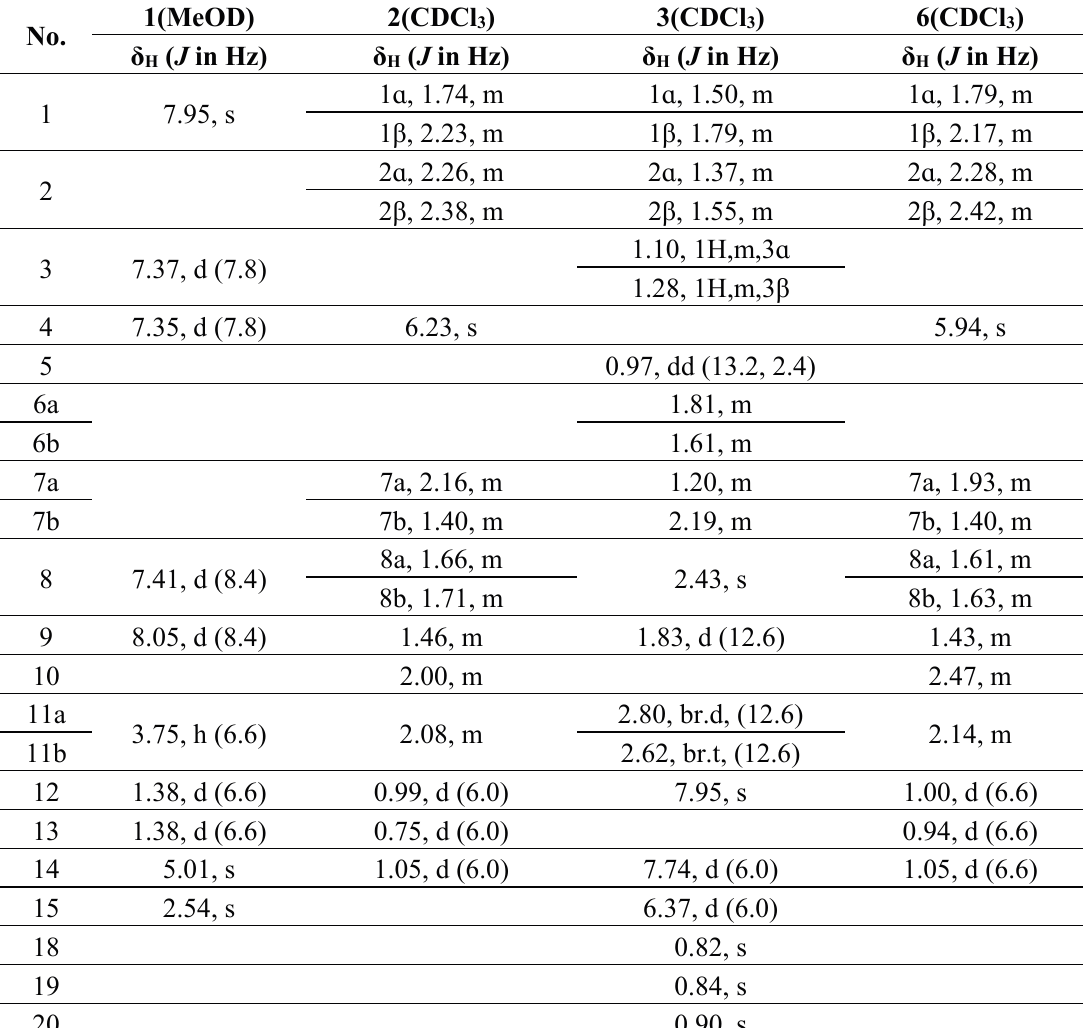
Table 1. The 1 H-NMR (600 MHz) spectroscopic data for compounds 1 – 3 and 6 . No.